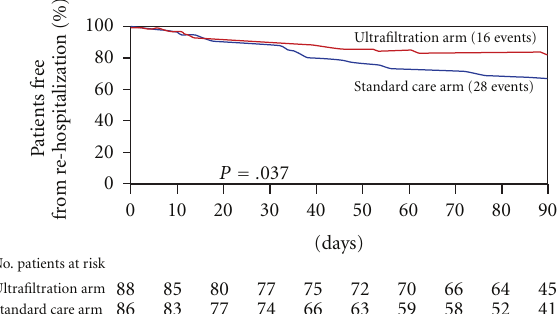
Figure 2: UNLOAD trial, freedom from rehospitalization. Kaplan- Meier estimate for freedom from rehospitalization for heart failure within 90 days of discharge in the ultrafiltration (red line) and usual care (blue line)